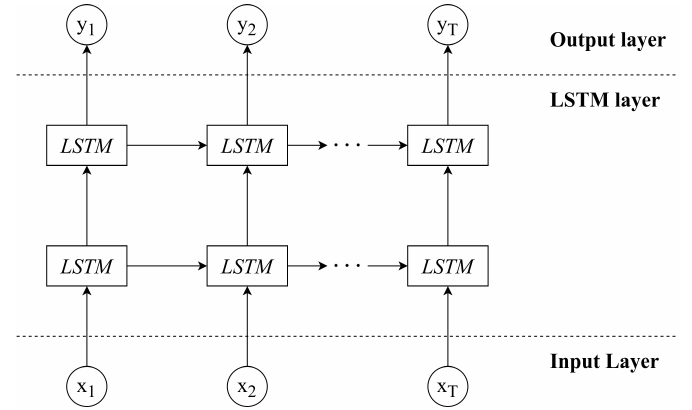
Figure 2. LSTM (Long Short-term Memory)network [15] for the user’s instantaneous QoE prediction. The network is composed of two LSTM layers. The inputs to the layers are four features including STSQ, PI, NR, and TR. The outputs combine the LSTM layers’ hidden states, representing the predicted instantaneous QoE